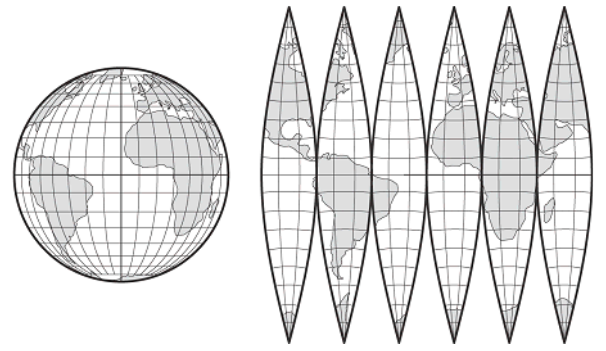
Figure 1. Sketch of Gauss-Krüger projection.